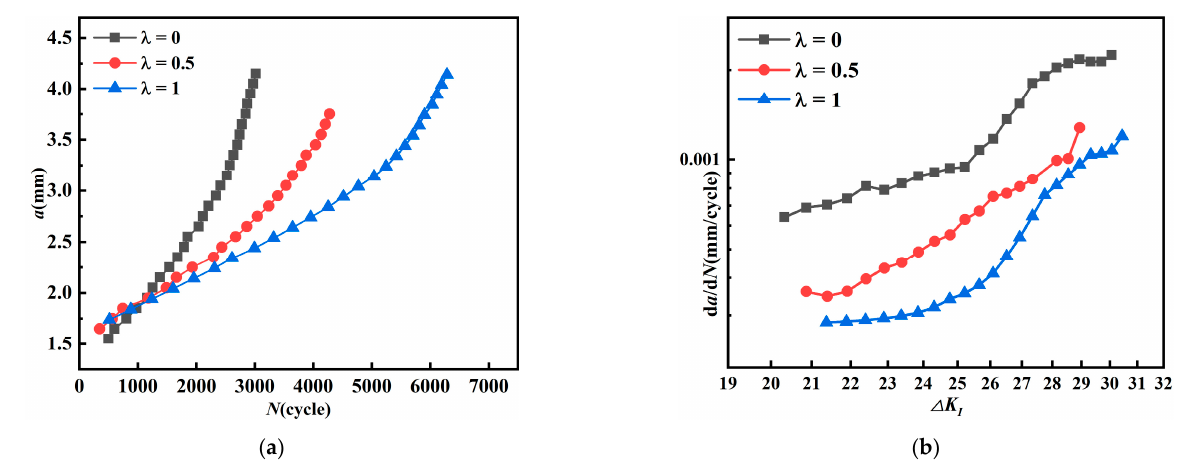
Figure 8. a-N curves and crack growth rate ( β = 90°). ( a ) a-N curves . ( b ) The relationship between da/dN and K I .